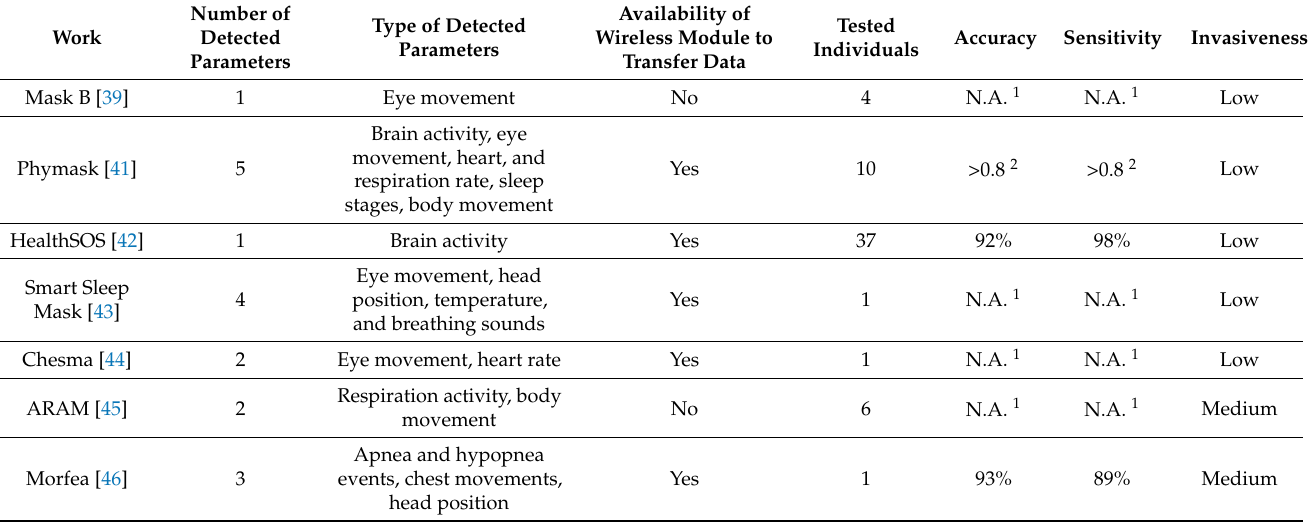
Table 1. Comparison among the scientific works previously discussed from the point of view of number and typology of detected parameters, availability of wireless connectivity to transfer data, and invasiveness.